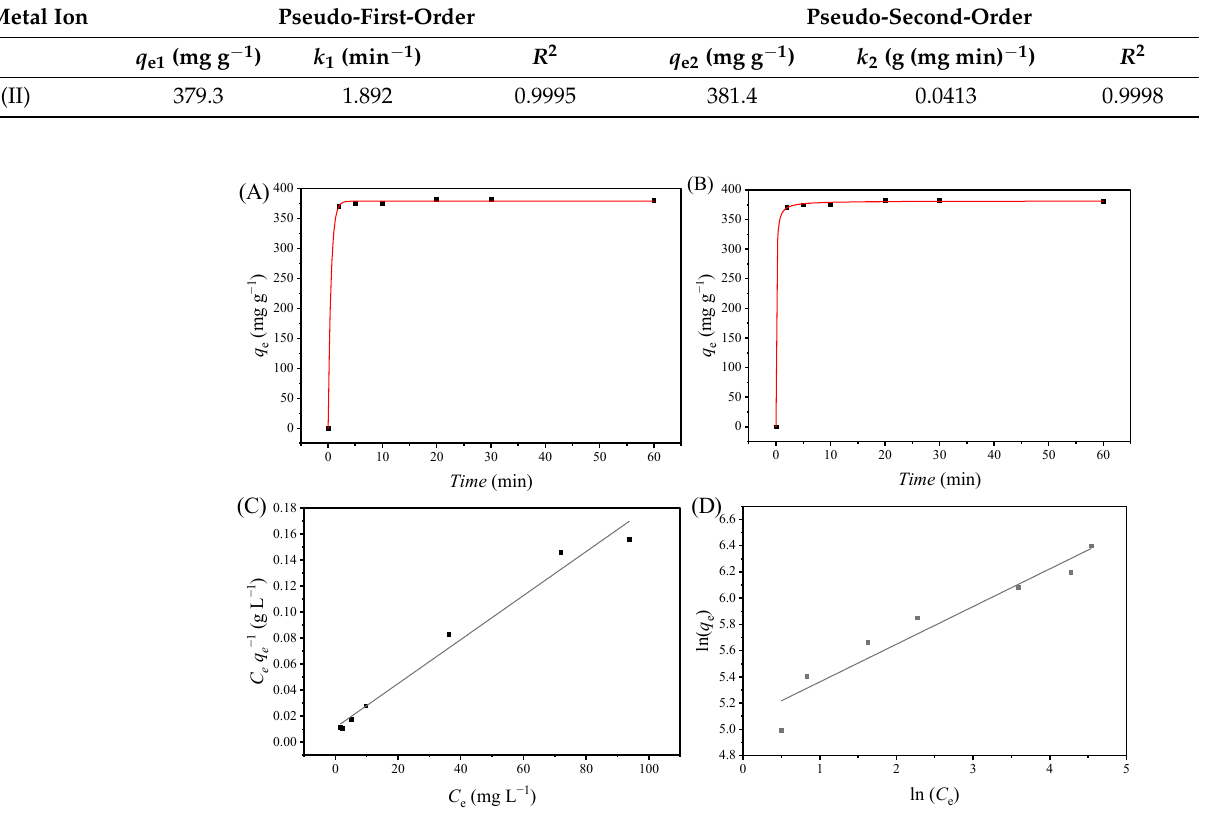
Figure 3. The adsorption kinetics of Pb(II) by PAA sponge fitted by ( A ) pseudo-first-order and ( B ) pseudo-second-order models, and the linear regression of the adsorption isotherm by fitting the equilibrium data with ( C ) the Langmuir and ( D ) the Freundlich adsorption models. The kinetic parameters and the thermodynamic parameters are presented in Tables 1 and 2. Table 1. Adsorption kinetics parameters of the fitted pseudo-first-order and pseudo-second-order models.